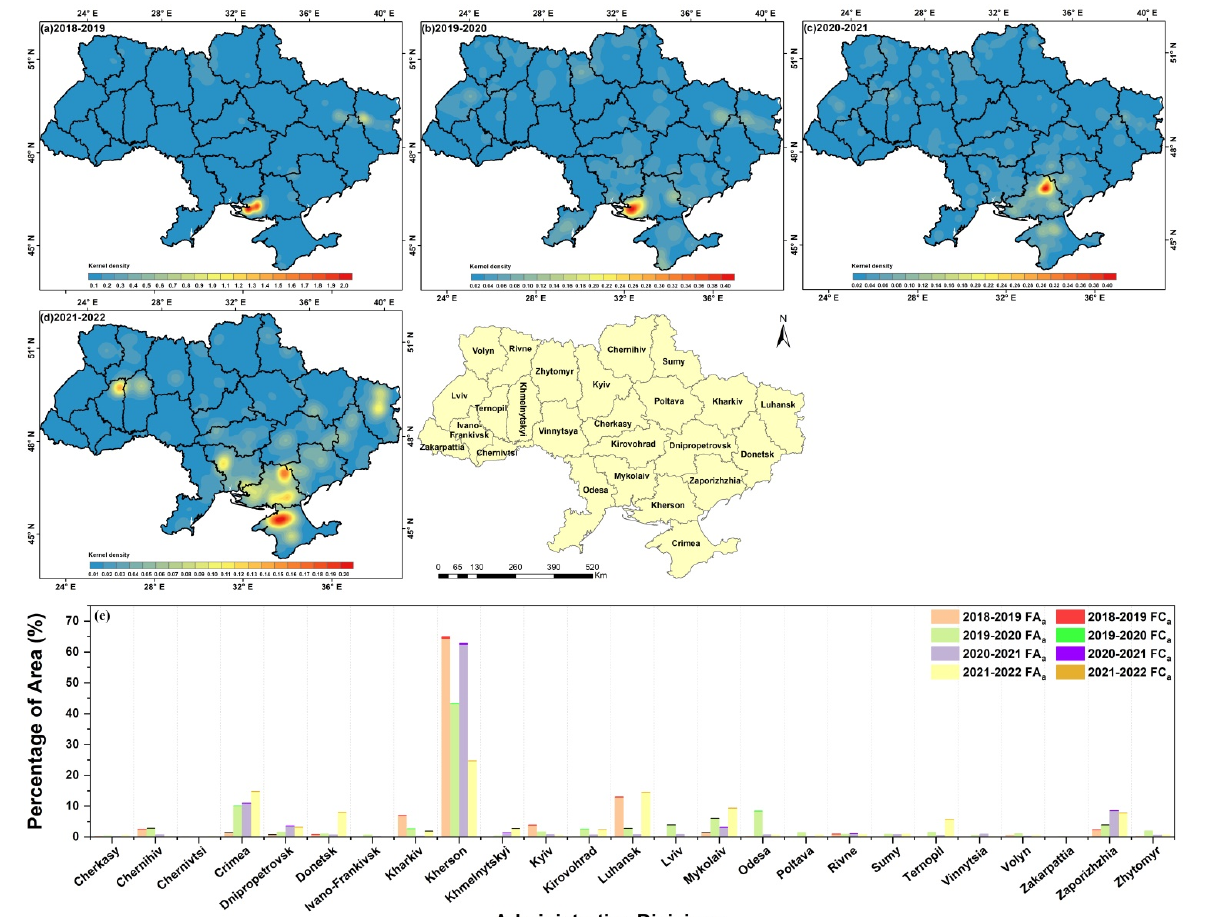
Figure 5. ( a – d ) illustrate the kernel density maps of abandoned cropland for each consecutive two ‐ year period from 2018 to 2022; ( e ) illustrates the statistical graph of area percentage of abandoned cropland. FA a represents the area of abandoned cropland in each administrative region as a percentage of the total abandoned cropland area in Ukraine. FC a represents the area of abandoned cropland as a percentage of the total fallowed cropland area in each administrative region.